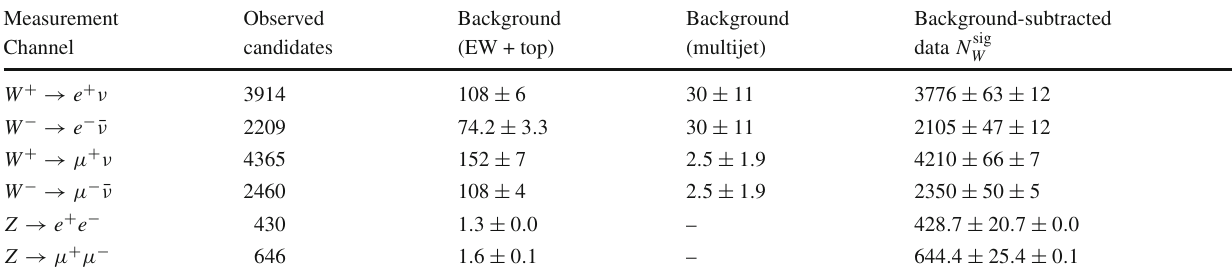
Table 5 The numbers of observed candidate events with the estimated numbers of selected electroweak (EW) plus top, and multijet back- ground events, together with their total uncertainty. In addition, the number of background-subtracted signal events is shown with the first